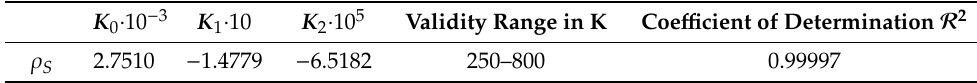
Table A1. Aluminum density correlation coe ffi cients.